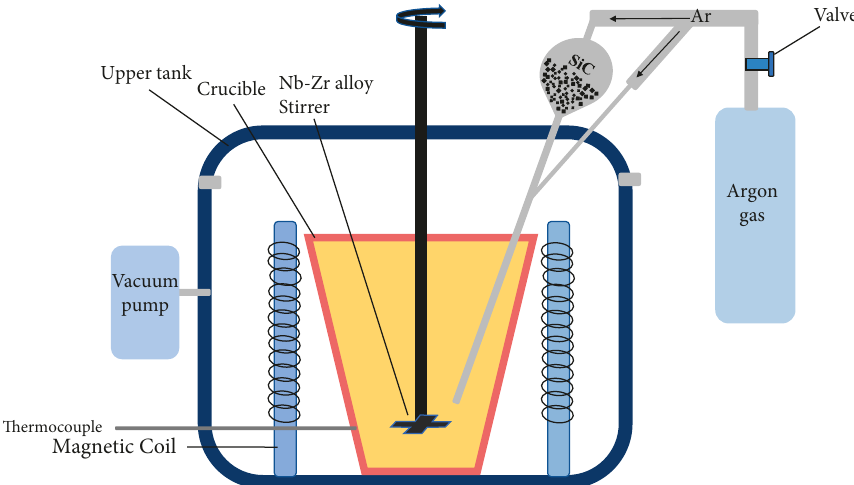
Figure 2: Schematic of the vacuum furnace.